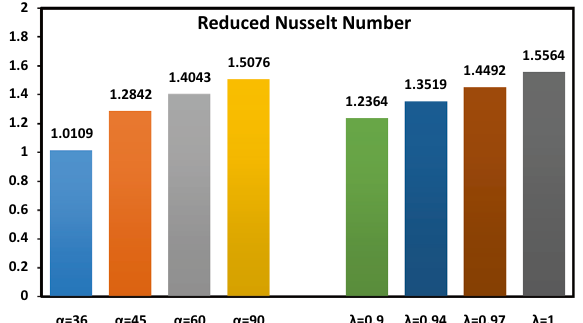
Figure 9. Values of the Nusselt number for different of α and (cid:31)